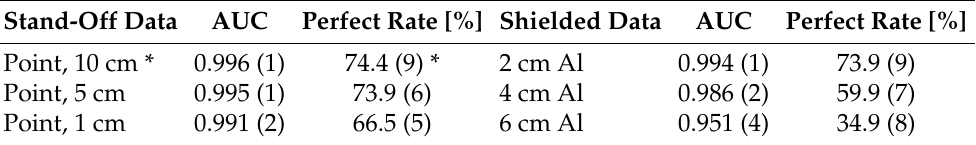
Table 4. Average perfect classification rates across data sets. All models were trained using the reference model architecture. Reference model developed on marked data set